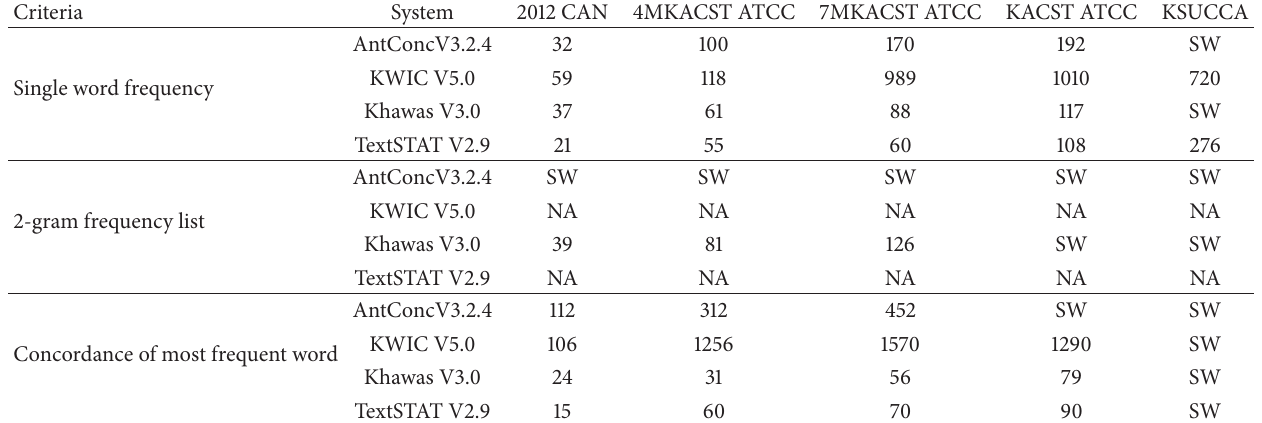
Concordance of most frequent